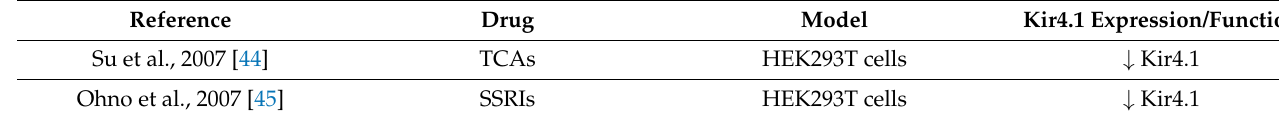
Figure 1. PRISMA flow diagram of search yield, screening, and inclusion steps. Table 1. Kir4.1 channel expression changes in depression. Table 2. Effects of antidepressant drugs on Kir4.1